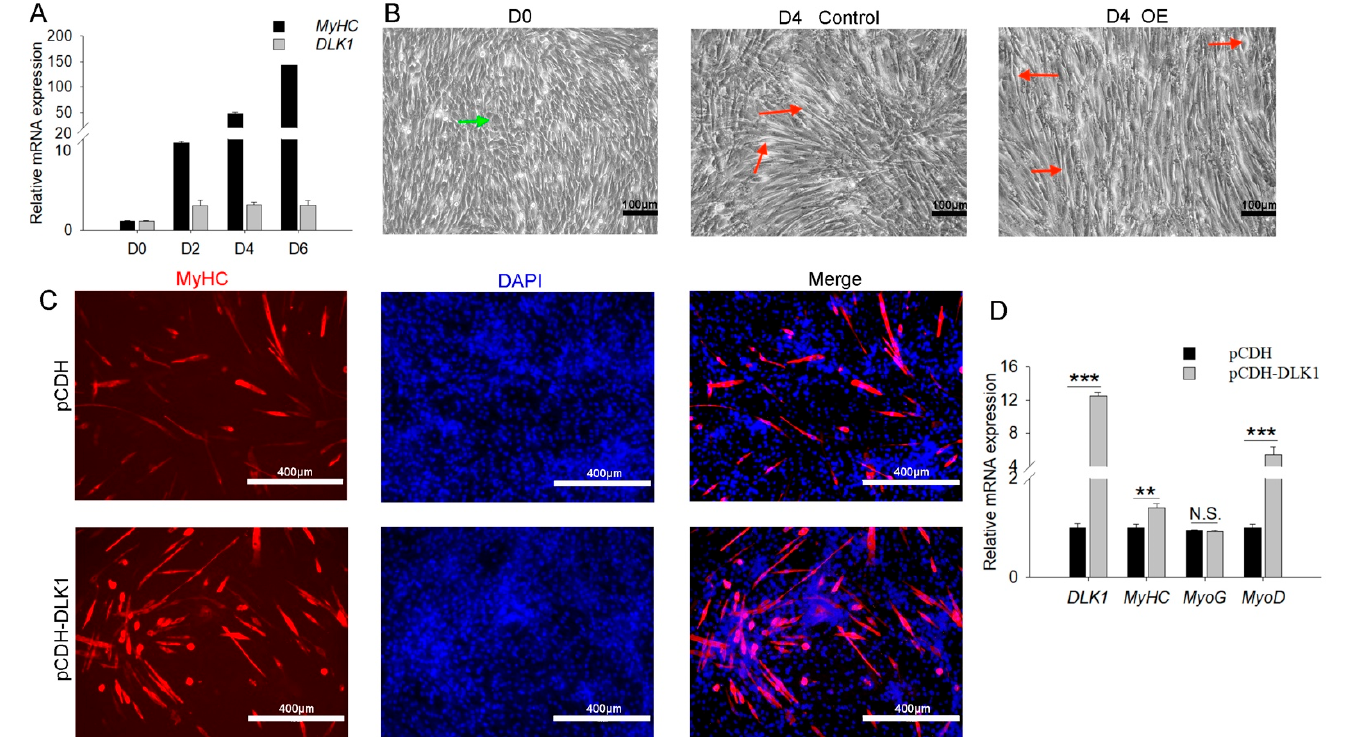
Figure 4. DLK1 improved cell differentiation. ( A ) Quantitative real-time polymerase chain reaction (qRT-PCR) results showed the expression profiles of the DLK1 gene during differentiation. MyHC is the myogenic-differentiation-indicator gene; ( B ) microscopic view of differentiated cells; D0 and D4 refer to differentiation after zero and four days. Control and OE represent cells transfected with pCDH and pCDH- DLK1 , respectively; scale bar = 100 µm; green arrows represent undifferentiated myoblasts that displayed a disorderly and irregular morphology; red arrows represent orderly bundles of muscle tubes. ( C ) Immunofluorescence staining for MyHC protein in pCDH- or pCDH- DLK1- treated myoblasts that were cultured for four days in differentiation medium. MyHC and the nucleus are stained in red and blue (DAPI), respectively; scale bar = 400 µm; ( D ) the mRNA expression of DLK1 and the differentiation marker genes, MyoD , MyoG , and MyHC, was quantified using qRT-PCR. ** p < 0.01, *** p < 0.001, N.S., not significant.